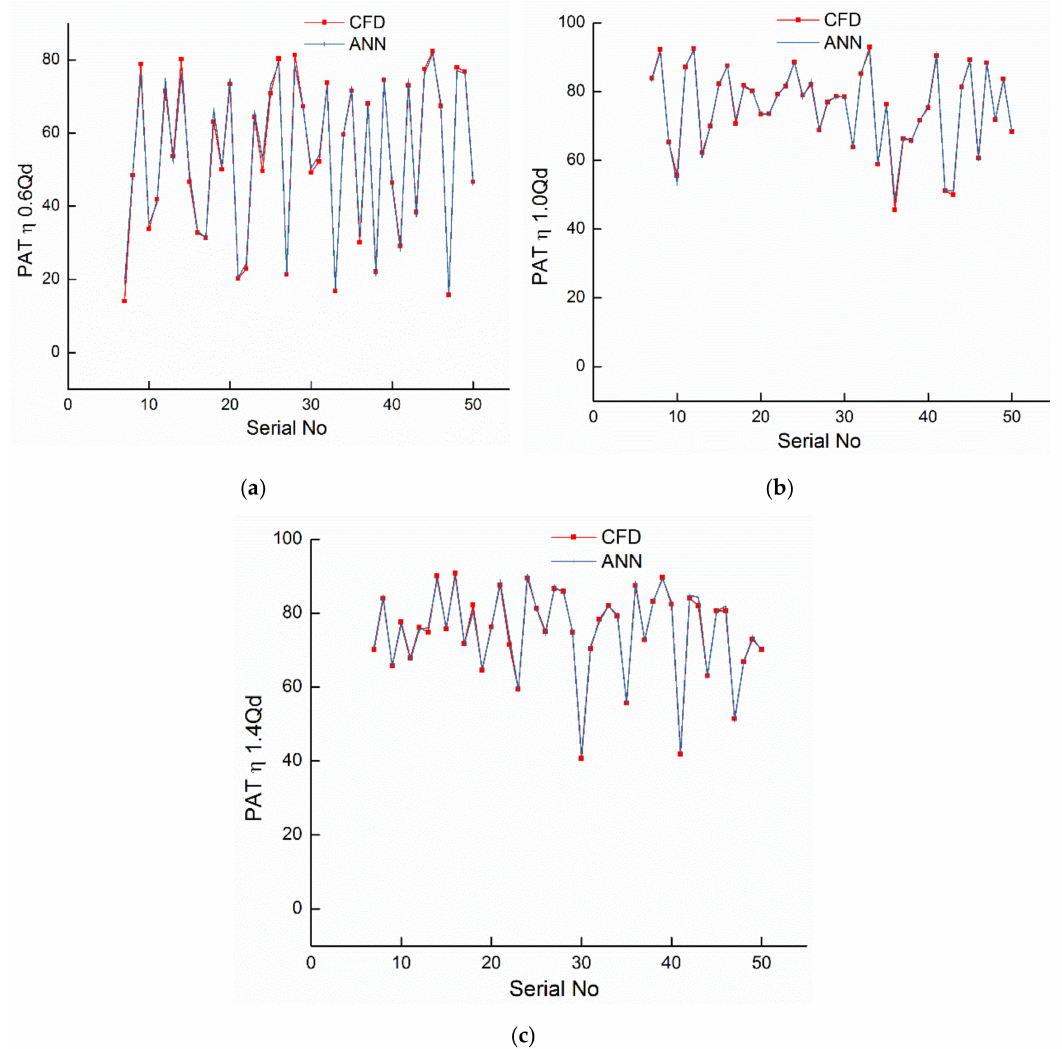
Figure 13. Validation of ANN prediction with CFD: ( a ) 0.6 Q d , ( b ) 1.0 Q d, and ( c ) 1.4 Q